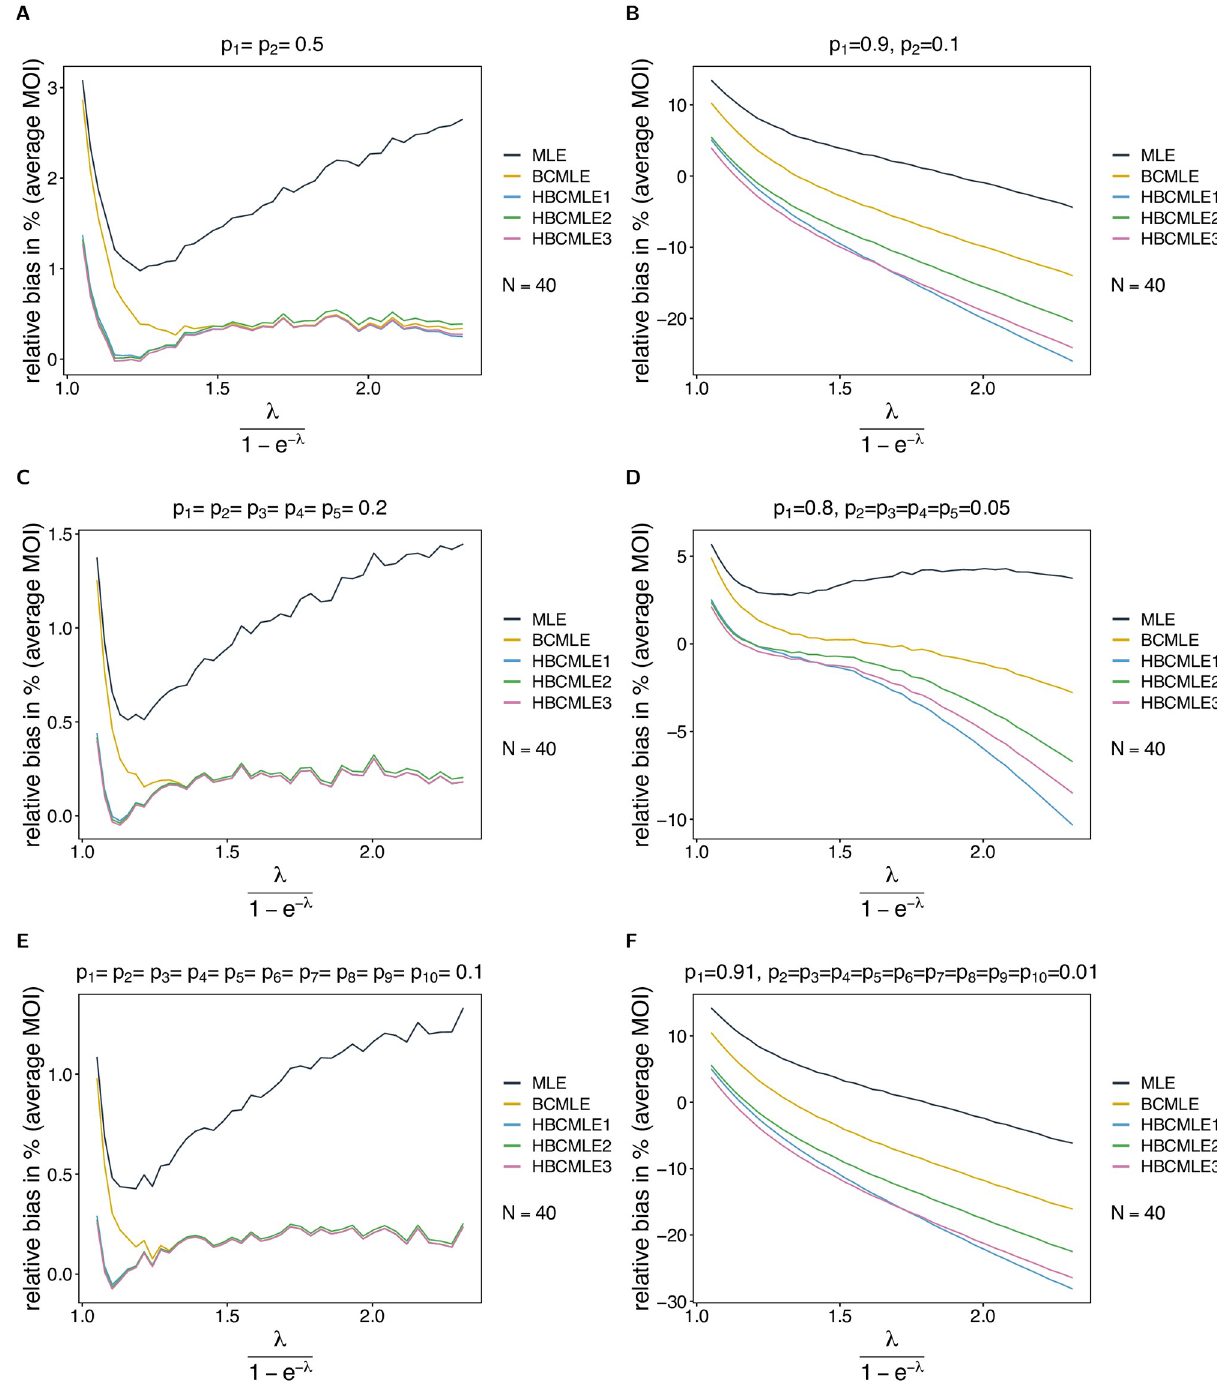
Fig 6. Bias of heuristically adjusted MOI estimators. Shown is the relative bias in % of the heuristically adjusted estimators (HBCMLE1— ^ c ð hbc 1 Þ , HBCMLE2— ^ c ð hbc 2 Þ , HBCMLE3— ^ c ð hbc 3 Þ ) along with the relative bias in % of the MLE ^ c and BCMLE ^ c ð bc Þ as a function of the true parameter ψ based on simulated data created by the conditional Poisson model. Each panel assumes a different lineage-frequency distribution p shown at the top of each panel. Colors correspond to different estimators. The relative bias in each panel is derived from S = 100, 000 randomly generated datasets of sample size 40.